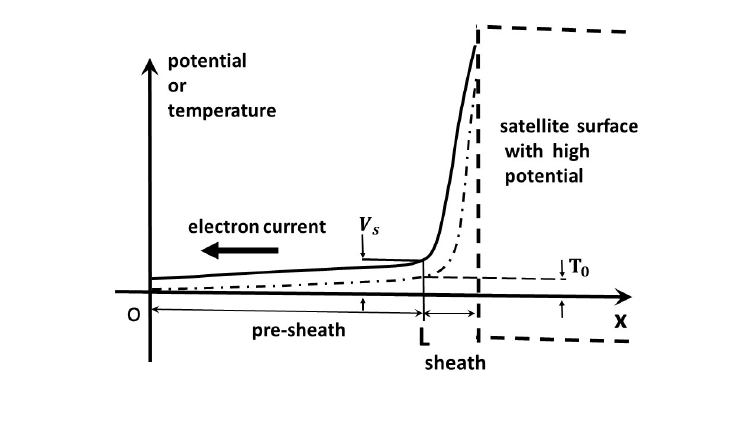
Figure 2. Illustration for the pre-sheath